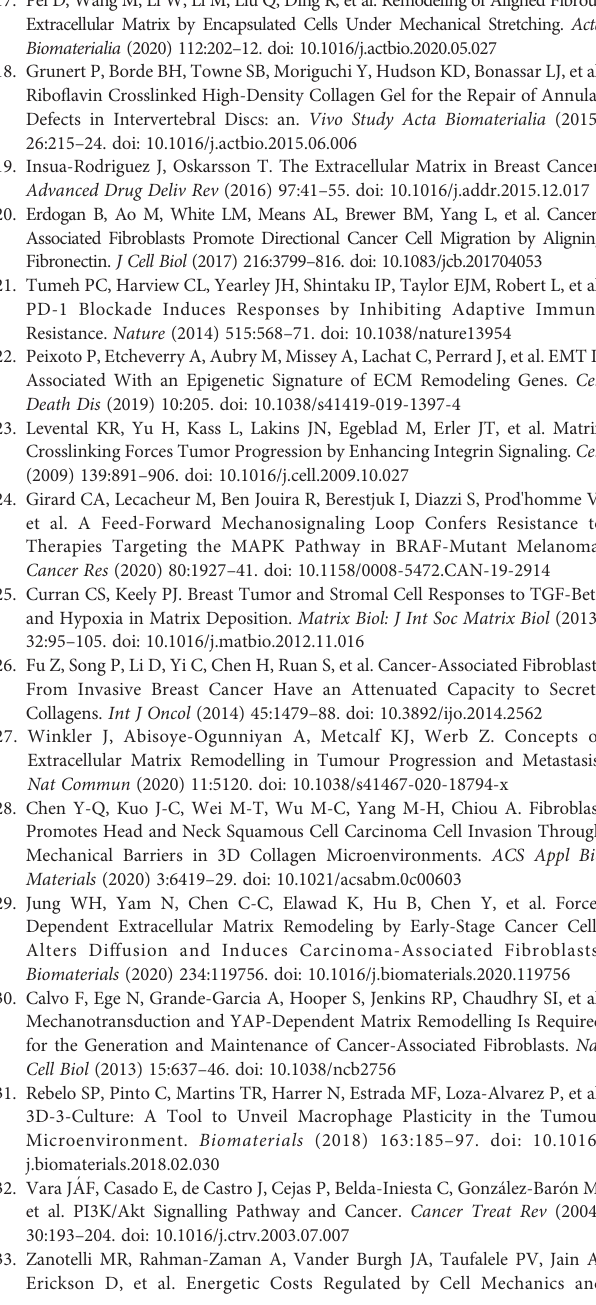
activated and activated groups. C. Immuno fl uorescence staining of a -SMA of NIH/ 3T-3 cells encapsulated in random and aligned collagen fi brils. D. Immuno fl uorescence staining of fi bronectin of NIH/3T-3 cells encapsulated in random and aligned collagen fi brils. (scale bar, 50 m m). * P < 0.05; ** P < 0.01; *** P < 0.001, **** P < 0.0001. Supplementary Figure 4 | Collagen density modulates CAF induction of NIH/3T- 3cells.A.Immuno fl uorescencestainingof a -SMAofNIH/3T-3cellsencapsulatedin low and high density of collagen fi brils. B. Immuno fl uorescence staining of fi bronectin of NIH/3T-3 cells encapsulated in low and high density of collagen fi brils. (scale bar, 50 m